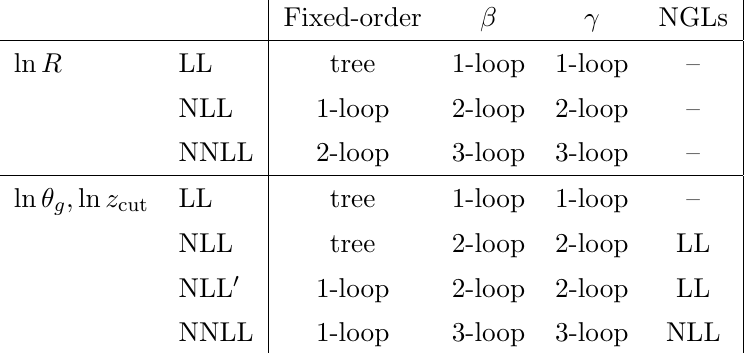
Table 1 . The necessary perturbative ingredients for the resummation of logarithms of R , (cid:18) g and z cut . In the columns we list the relevant (cid:12)xed order ingredients, the QCD beta function, the anomalous dimensions and the non-global logarithms. The non-cusp part of anomalous dimension only enters at one-loop order lower than what is shown